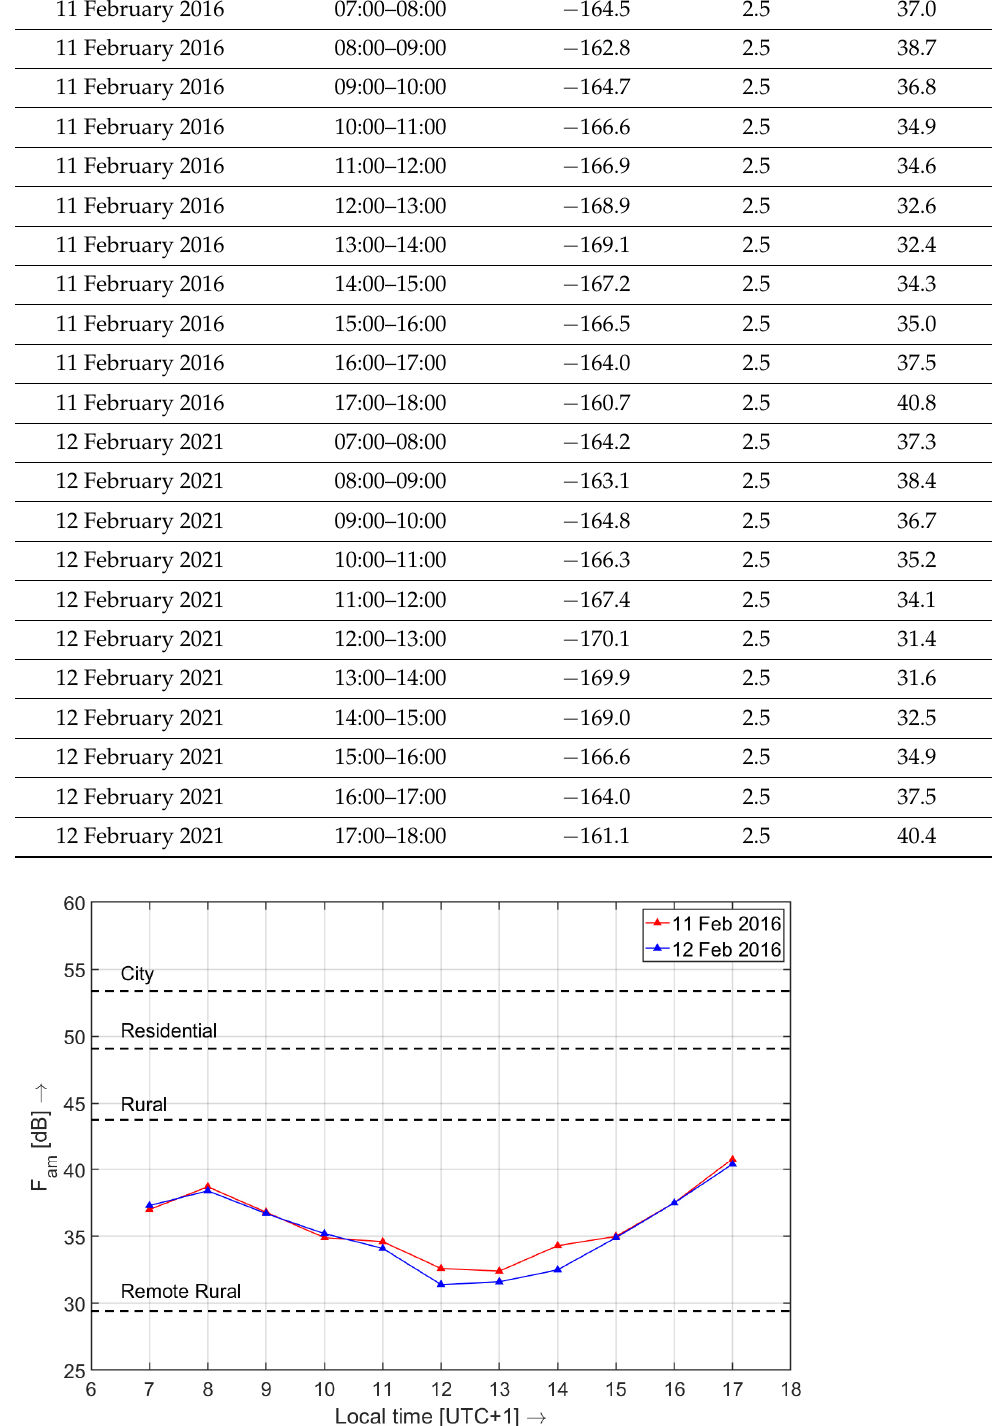
Figure 14. Graphical representation of the statistics of the ambient noise factor values, calculated from all measurements together. The median value is shown as a horizontal dash. The 10-th to 90- th percentile are shown as a box. The vertical lines show the extreme values. The predicted values from Recommendation ITU-R P.372-15 are shown as dashed lines. 5. Discussion